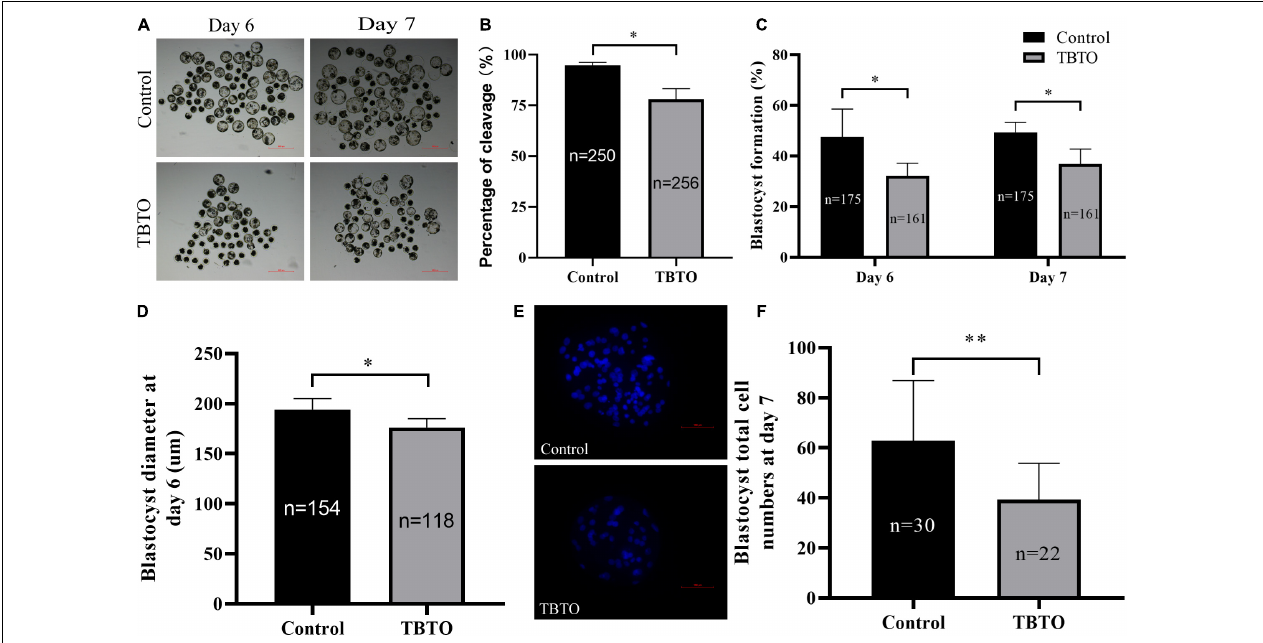
FIGURE 3 | Developmental competence of porcine oocytes after TBTO exposure. (A) Representative images of PA embryo development on day 6 (top) and day 7 (bottom) in the control and TBTO exposure group at the end of the IVM period. Scale bar = 500 µ m. Percentages of cleavage (B) and blastocyst formation (C) in the control and TBTO exposure group. (D) Blastocyst diameter in the control and TBTO exposure group. (E) Representative images of Hoechst 33342 staining of blastocysts on day 7 in the control and TBTO exposure group. Scale bar = 100 µ m. (F) Blastocyst total cell numbers in the control and TBTO exposure group. The numbers of embryos examined from the different groups are indicated by the bars. ∗ p < 0.05; ∗∗ p < 0.01 compared to the